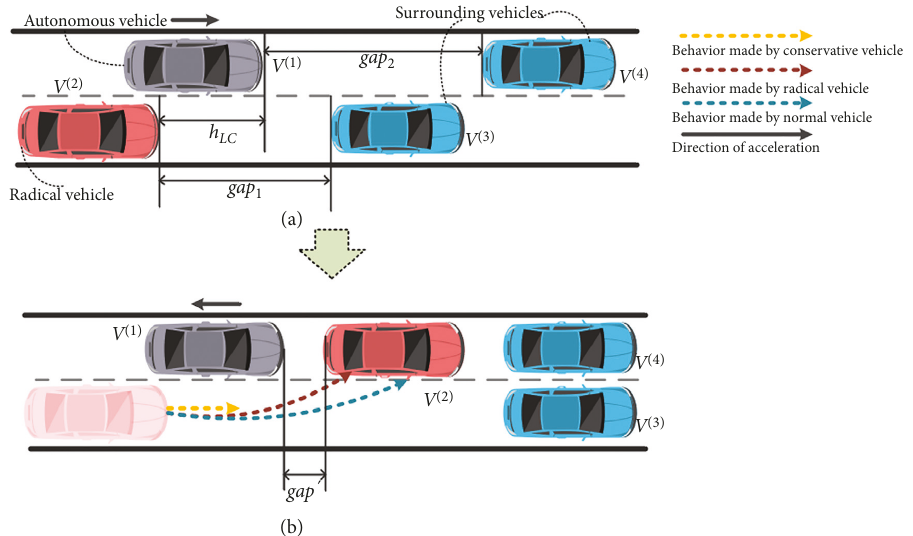
Figure 3: Lane-changing behavior in a heterogeneous scenario. (a) Initial scenario, (b) different performance of traffic participants completing lane-changing behavior, with aggressive vehicles generating more challenging scenarios, while vehicles with conservative sampling strategy or normal vehicles presenting a significantly lower degree of challenge to the